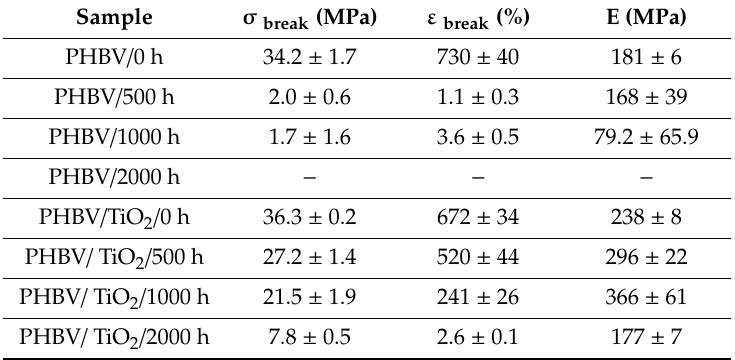
Table 5. Mechanical properties of the neat PHBV and the PHBV / TiO 2 after the di ff erent periods of accelerated